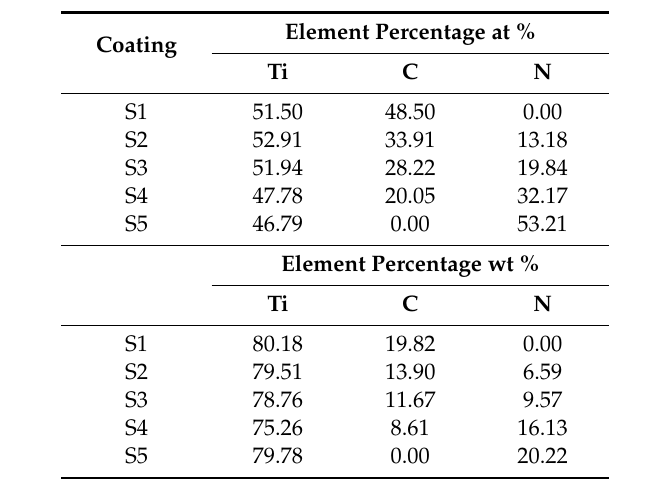
Table 2. Chemical composition of tested coatings